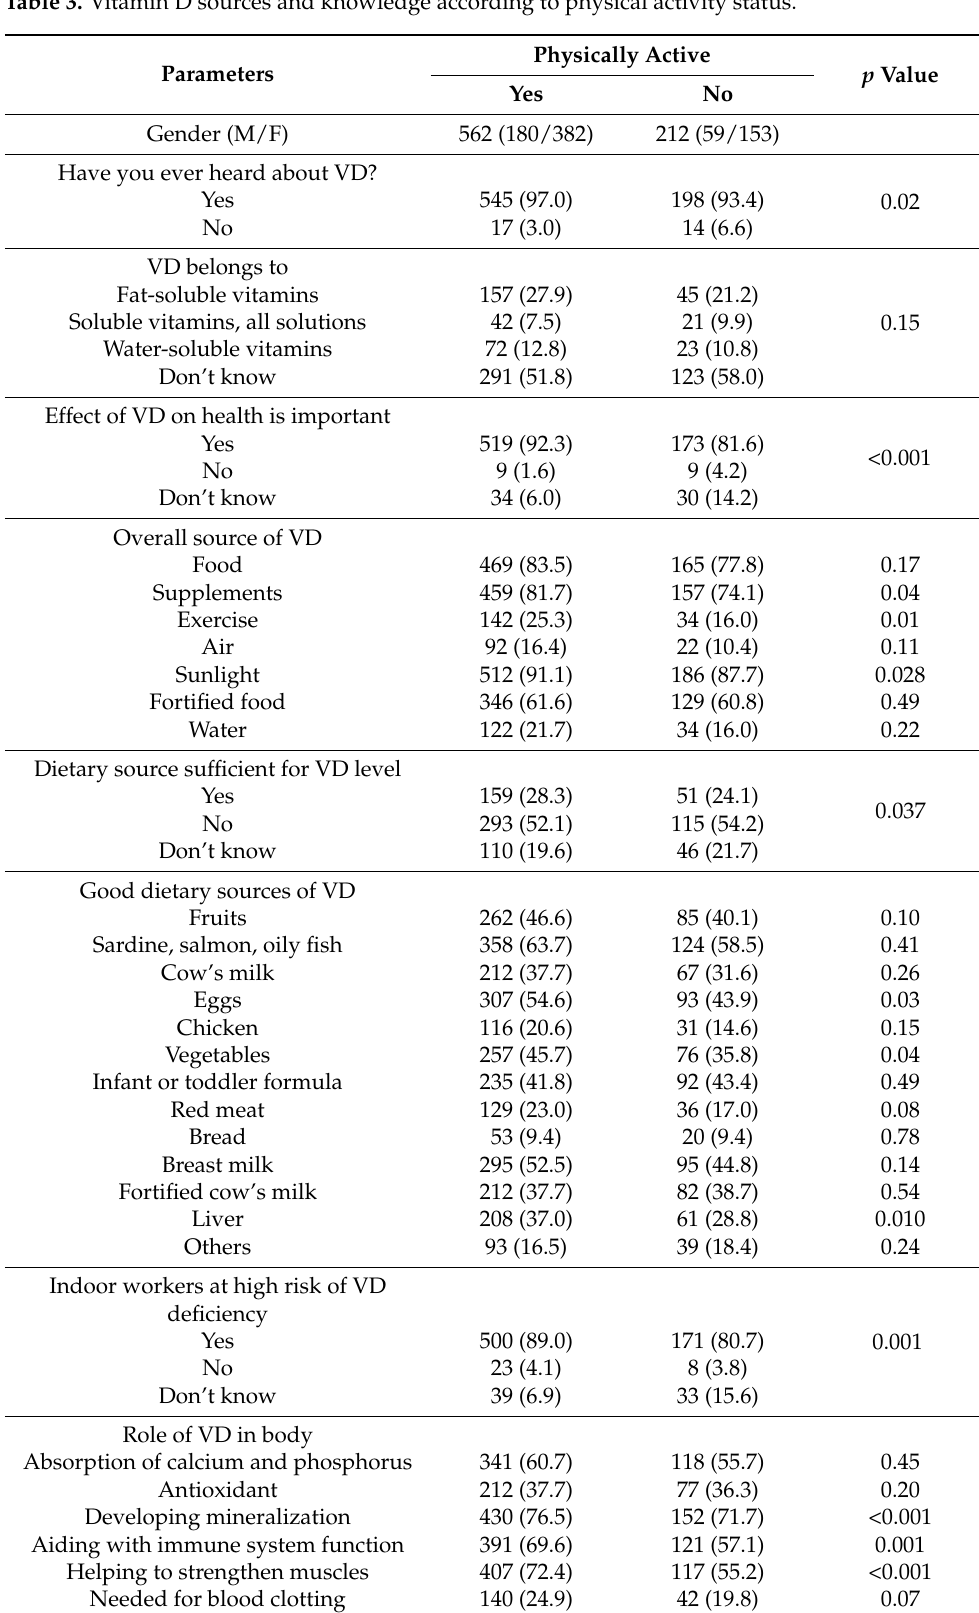
Table 3. Vitamin D sources and knowledge according to physical activity